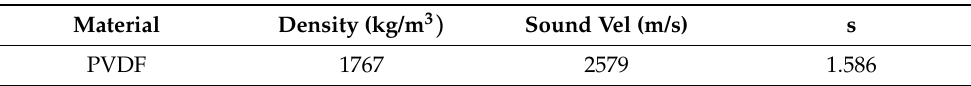
Table 4. Material parameters of PVDF required to model underwater explosion based on shock Equation of State [19]. Material Density (kg/m 3 ) Sound Vel (m/s) s PVDF 1767 2579